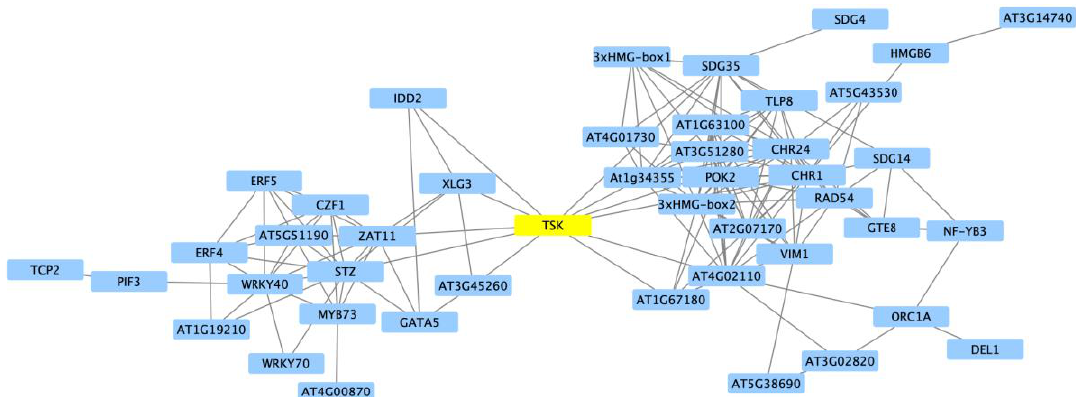
Figure 5. Analysis of transcription factor interactions within cluster L1 links the hallmarks of the soybean iron stress response. We used the STRING database to analyze the Arabidopsis homologs of L1 transcription factors. This analysis identified two networks of transcription factors (blue), linked by a single transcription factor, TSK (yellow). The network on the left is associated with known defense and stress TFs. The network on the right is associated with DNA replication, repair, methylation and gene silencing TFs. TSK is required for the induction of heat stress memory genes, mediates the inheritance of chromatin states across DNA replication and cell division and is associated with abiotic and biotic stress responses.